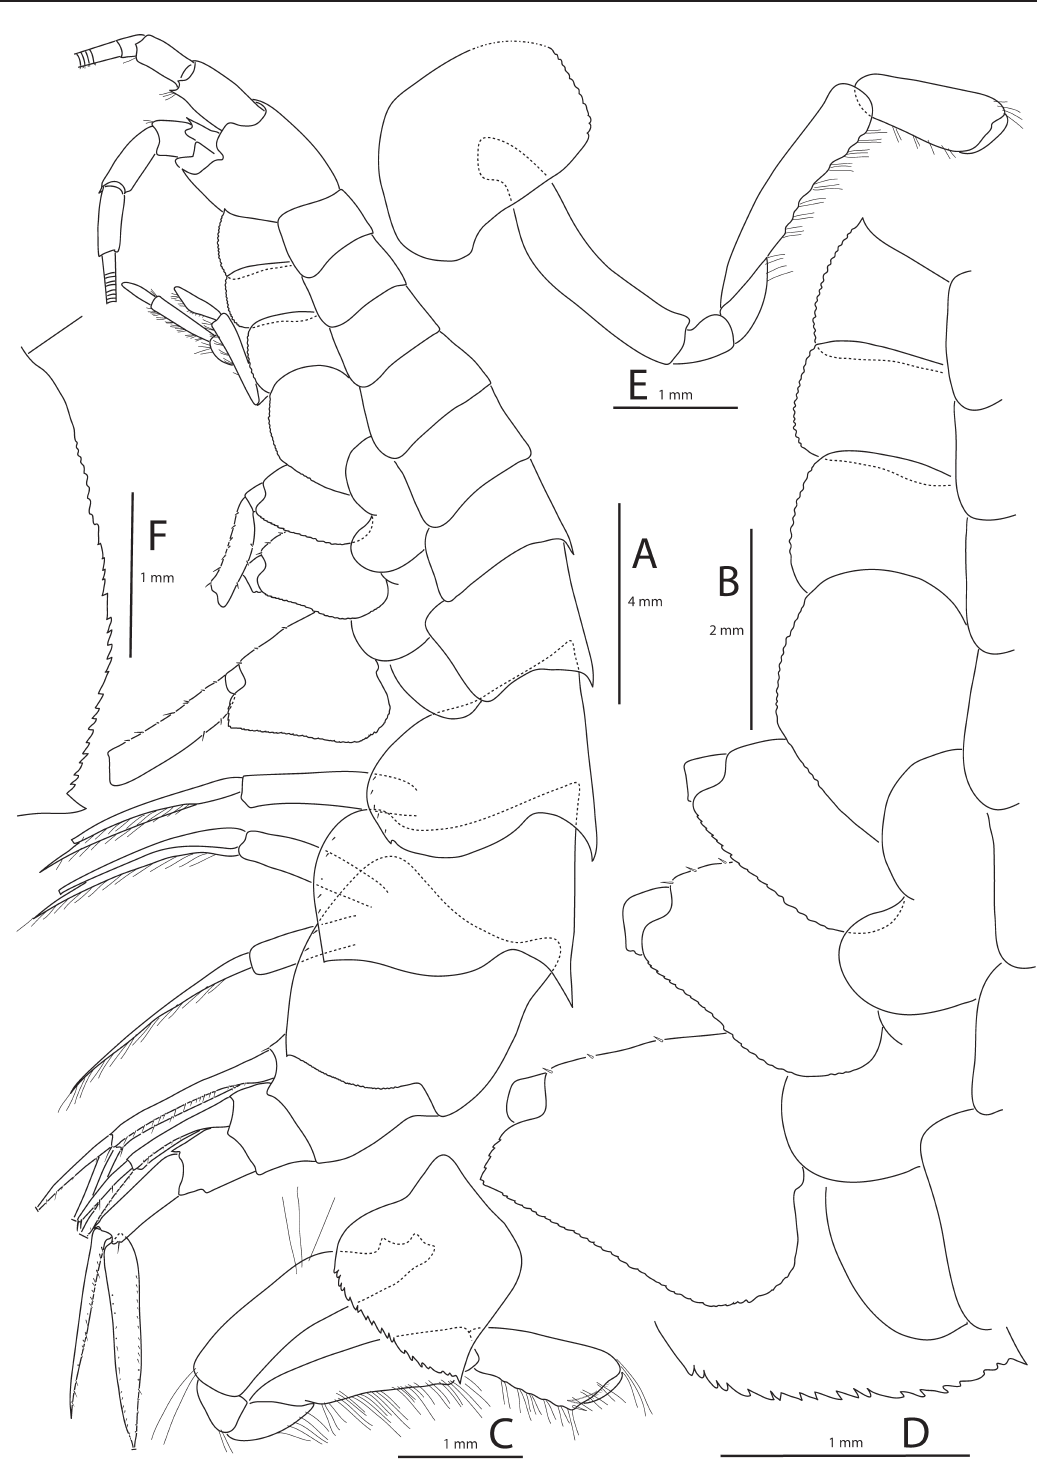
Fig. 8. Halirages qvadridentatus G.O. Sars, 1877 (syntypes of Halirages elegans Norman, 1882), Faeroe Islands, RV Knight Errant , stn 8. A-B . largest syntype, ♂ (30 mm); C-F . microscopical preparations by Norman. A . habitus. B . ventral part of pereion with coxal plates and proximal part of posterior pereiopods. C . right Gn1 (coxa broken in two parts on slide and reassembled on drawing). D . ventral margin of right coxa 1. E . right Gn2 (anteroventral corner of coxa indistinct, hidden by varnish on border of microscopical preparation). F . posterior border of